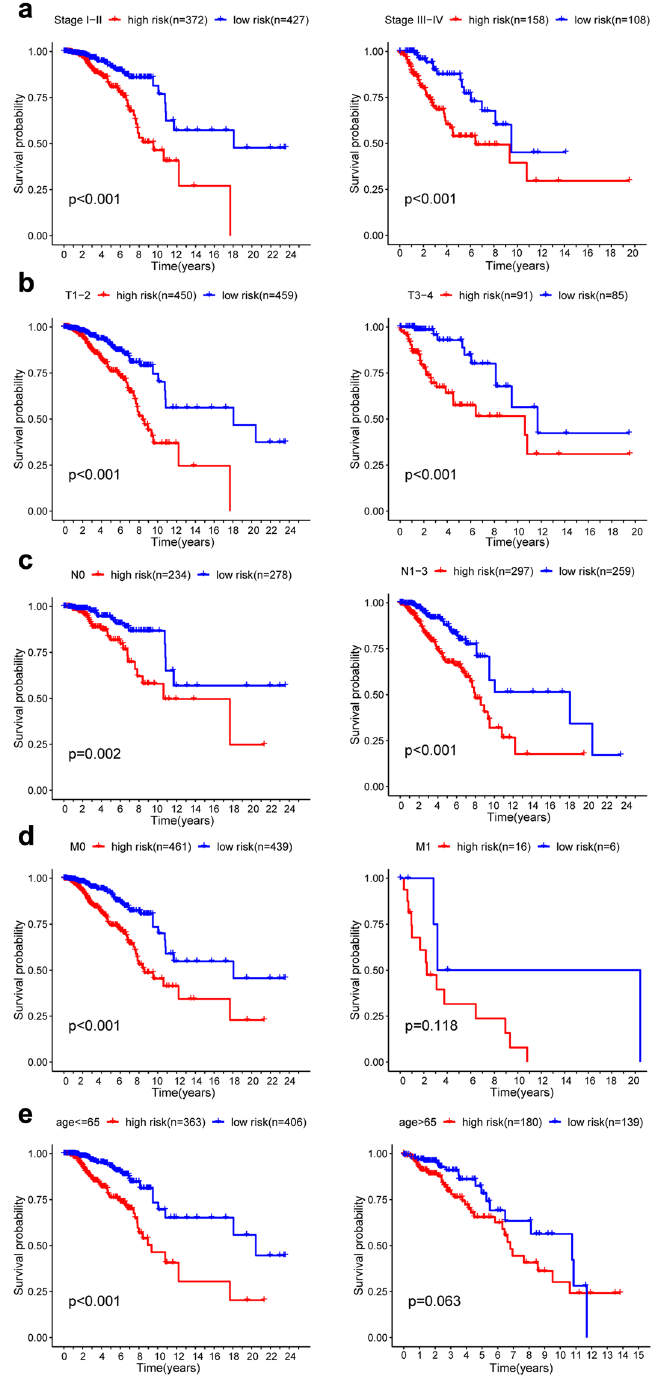
Figure 7. Kaplan–Meier curves for the prognostic value of the signature of risk parameter in each clinical feature for the patients. ( a ) Age, ( b ) stage, ( c ) T classification, ( d ) N classification, ( e ) M